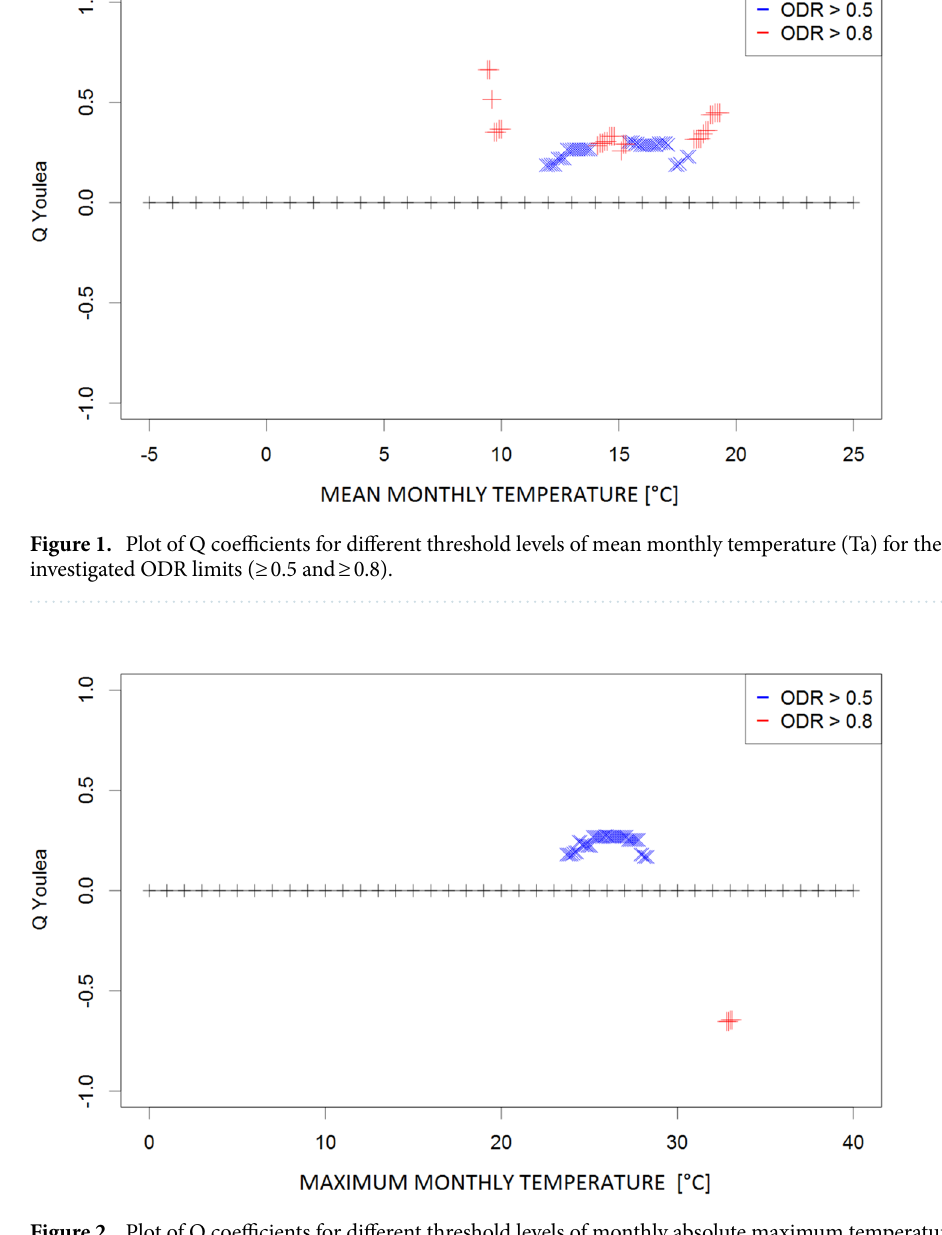
Figure 2. Plot of Q coefficients for different threshold levels of monthly absolute maximum temperature (Tx_ ab) for the investigated ODR limits (≥ 0.5 and ≥